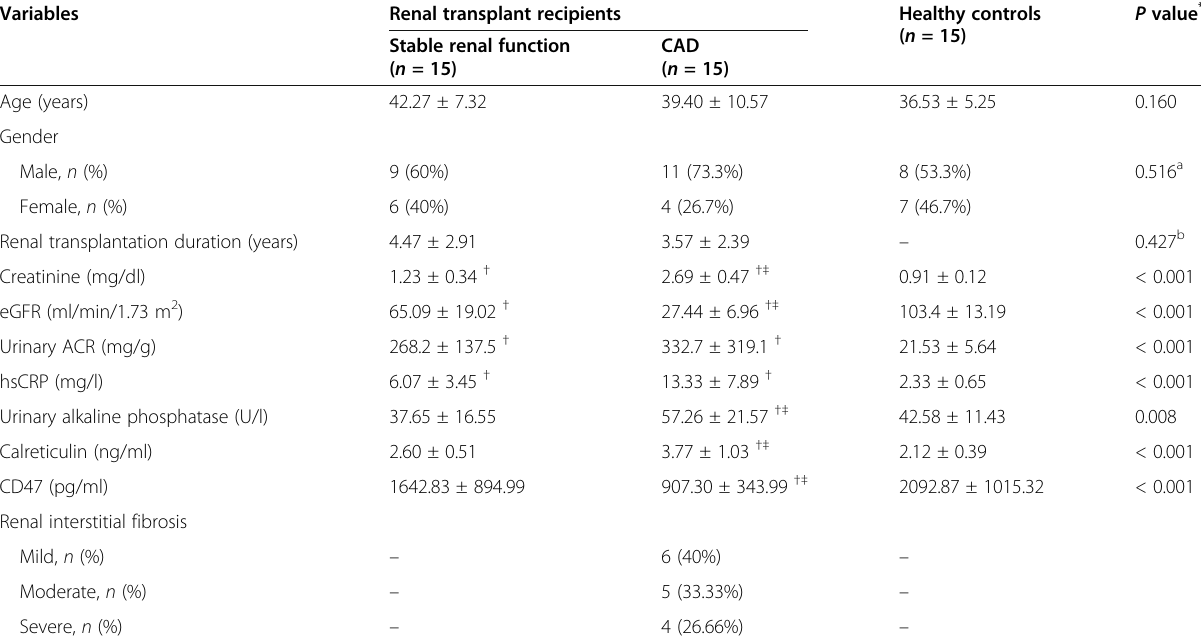
Table 1 Characteristics of renal transplant recipients with stable renal function and chronic allograft dysfunction (CAD) and healthy